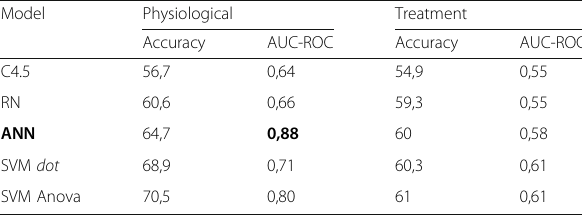
Table 1 (abstract 000675). See text for description